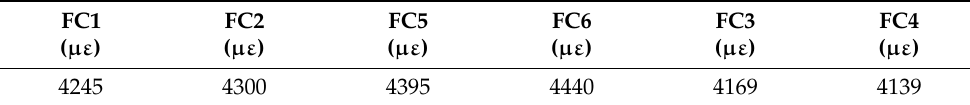
Table 9. Final strain subjected to FRP